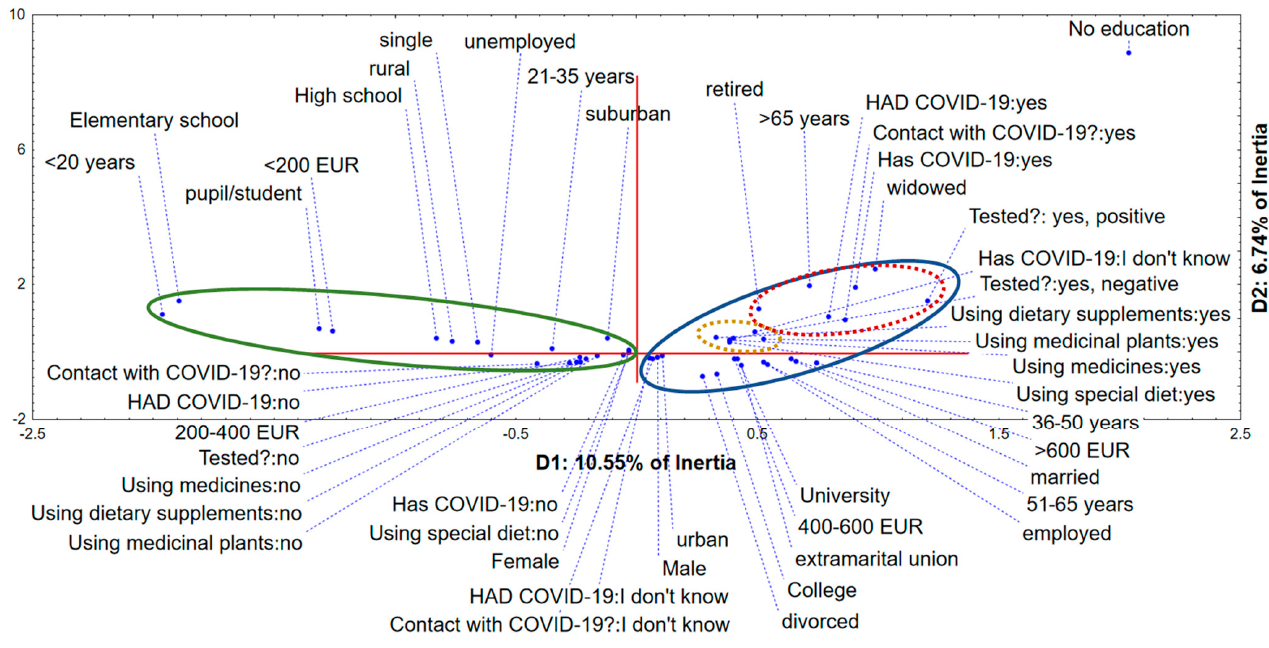
Figure 1. Multiple correspondence analysis—the position of recorded respondents’ answers in the space defined by the first two dimensions.